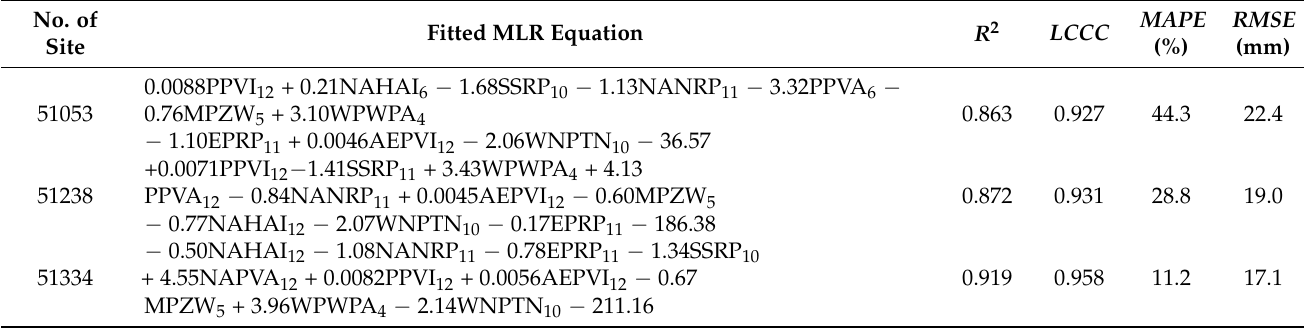
Table 2. The fitted MLR equations between monthly D and the selected key circulation indices of 9 representative sites in northwestern China (the subscript represents the lagged